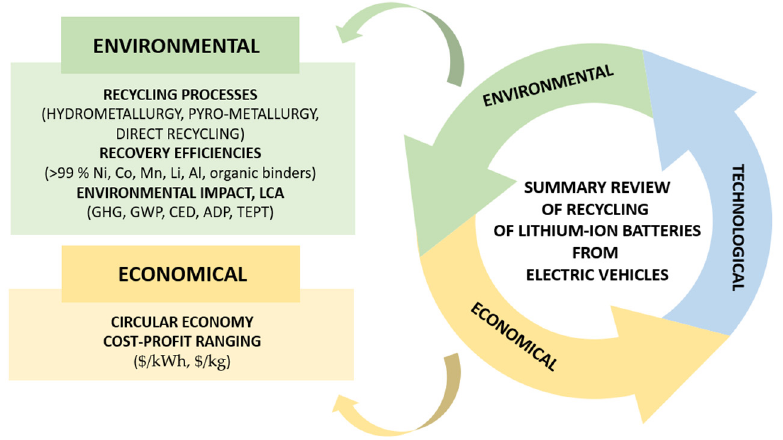
Figure 9. The summarizing figure of the second part of the literature review on recycling lithium- ion batteries from electric vehicles focused on environmental and economic